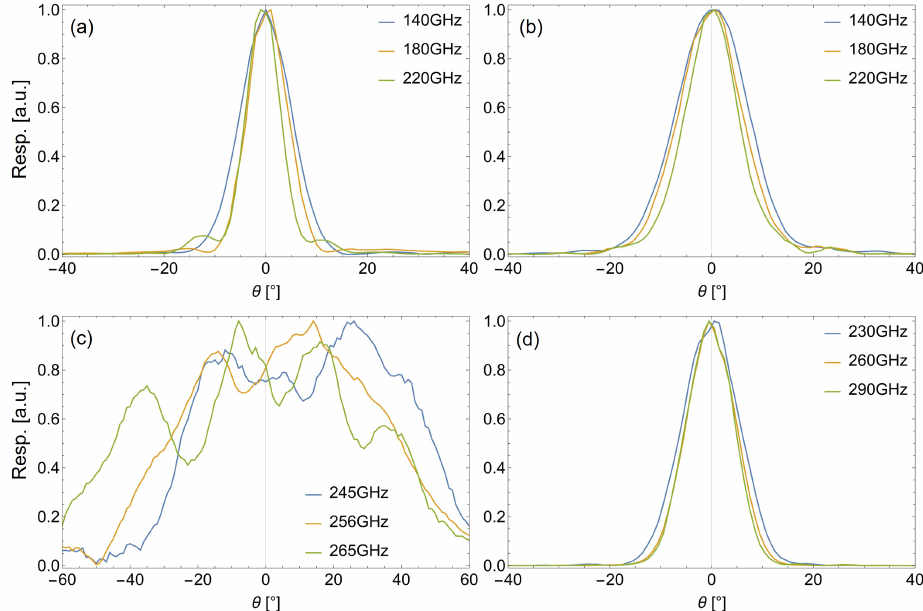
Figure 6. Frequency dependence of the angular characteristics of the detectors: ( a ) QOD, ( b ) WR51, ( c ) FET and ( d ) WR34.